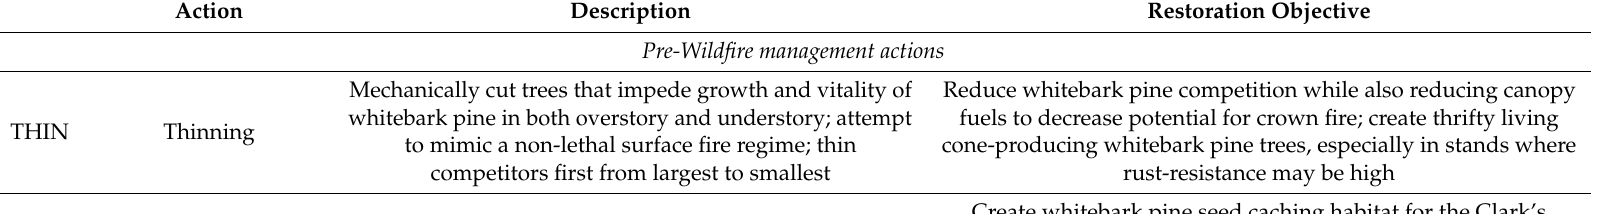
Table 2. Definitions, descriptions and related restoration objectives for all wildfire management options in Table 1. CBH-canopy base height and CBD-canopy bulk